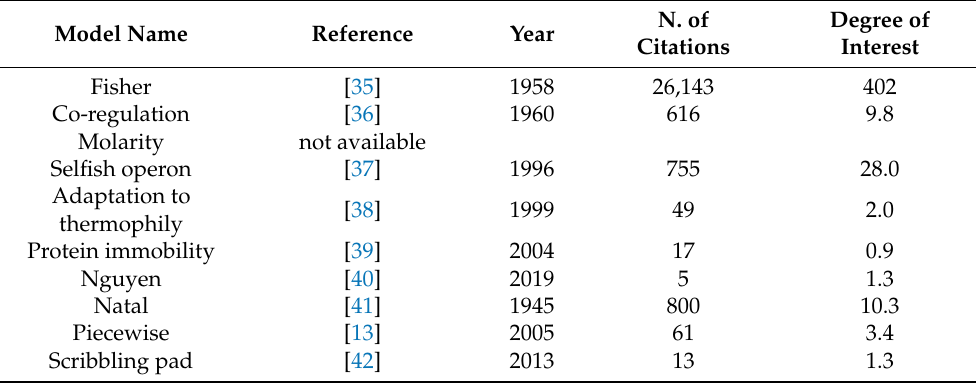
Table 1. List of the proposed models for the origin and evolution of operons, year of publication, number of citations according to Google Scholar (accessed on 14 February 2023), and “degree of interest” of the model, calculated as the number of citations normalized on the number of years since